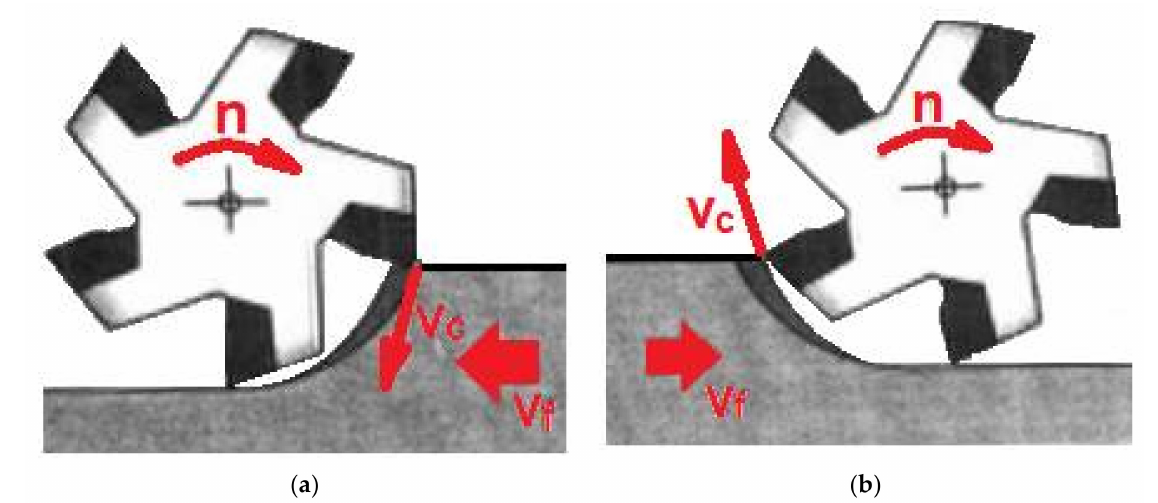
Figure 2. A schematic layout of climb milling and up milling. ( a ) climb type; ( b ) classical